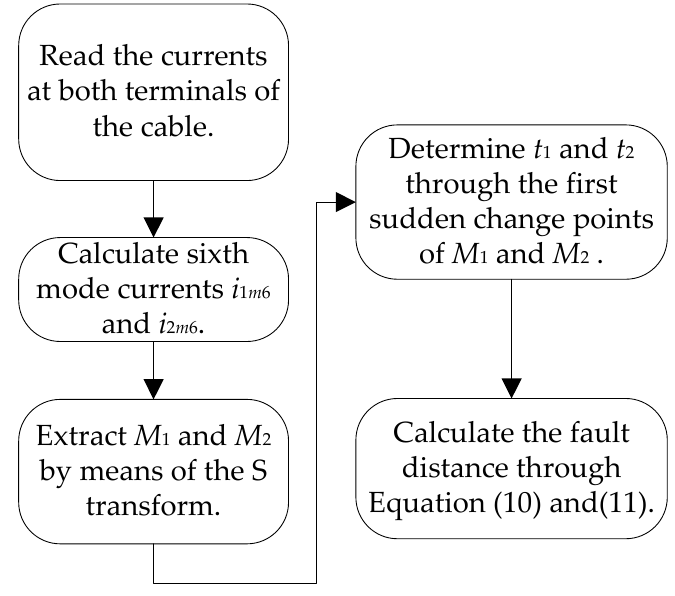
Figure 7. Flowchart of the proposed fault-location method.